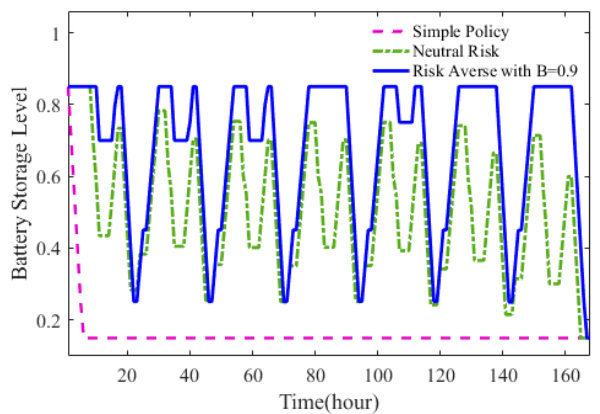
Figure 4. Battery storage level for β = 0.9.